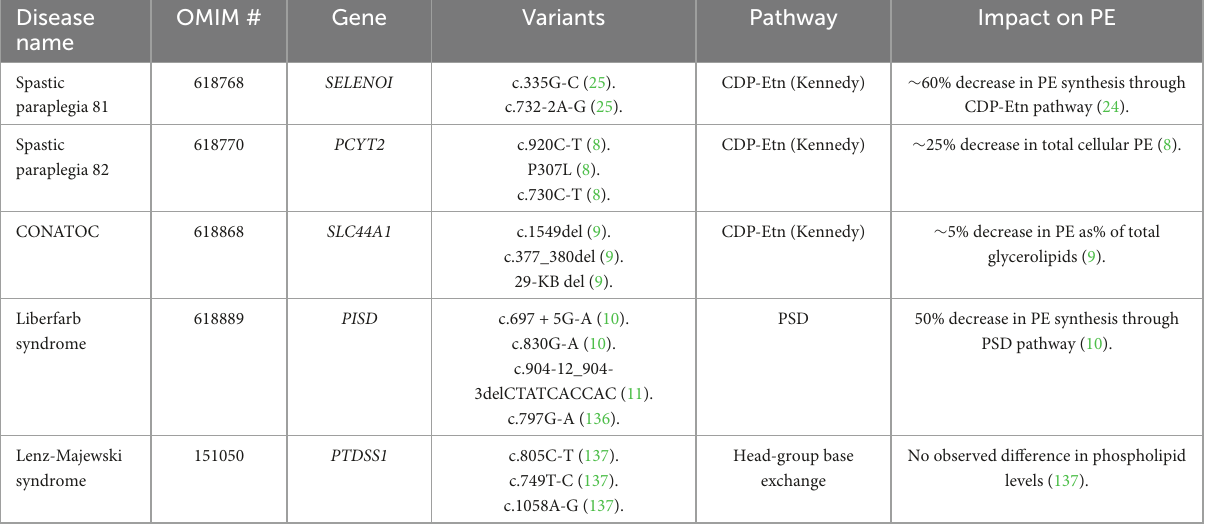
TABLE 1 Summary of known neurodegenerative genetic disorders that impact PE homeostasis by downregulating a major biosynthetic